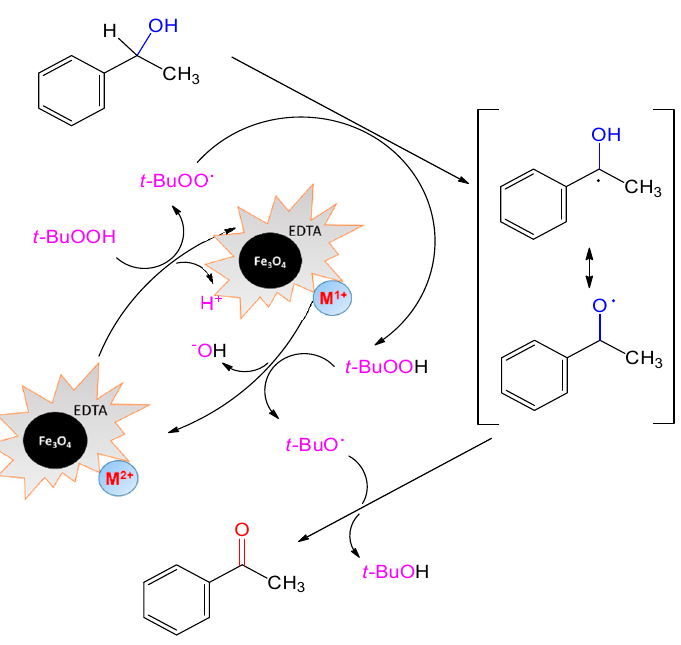
Scheme 2. Proposed mechanism for Fe 3 O 4 @EDTA-M 2+ [M 2+ = Mn 2+ ( 1 ), Fe 2+ ( 2 ), Co 2+ ( 3 ), Ni 2+ ( 4 )